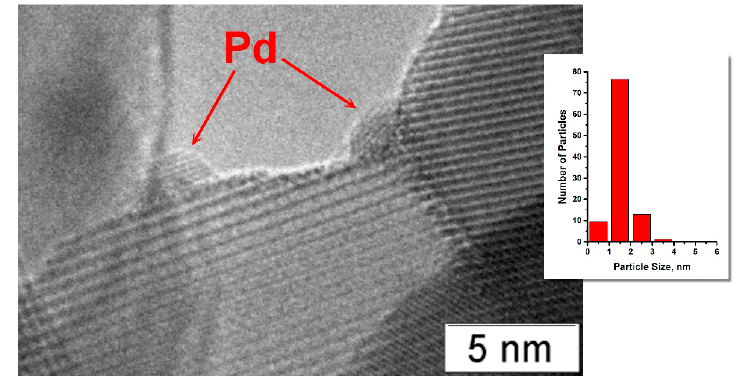
Figure 4. Transmission electron microscopy image of 0.8% Pd/ZrO 2 sample after calcination at 500 °C.